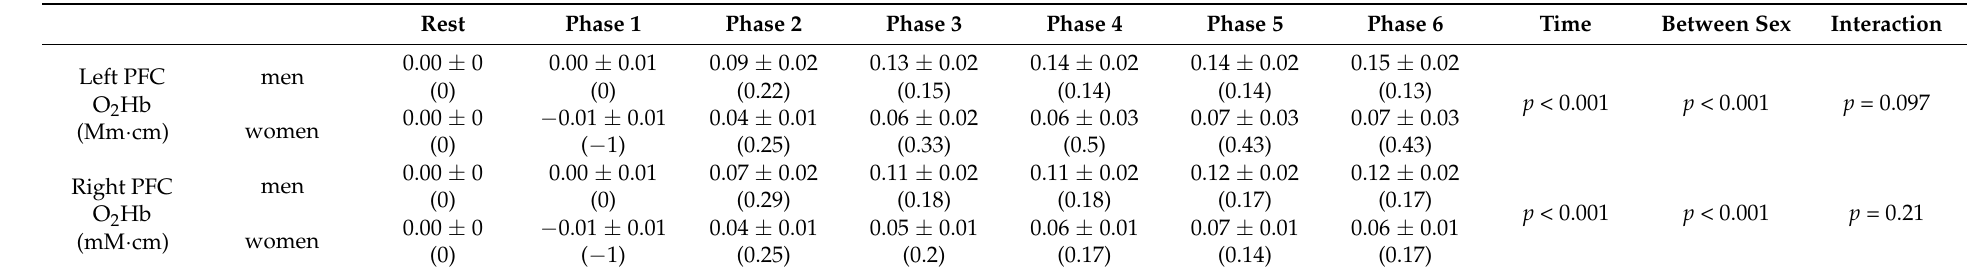
Table 2. Changes in PFC O 2 Hb during exercise.